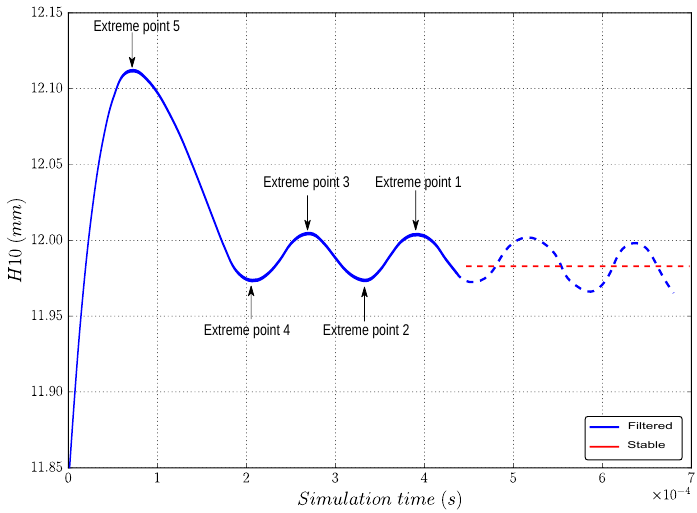
Figure 7. H 10 of dynamic tensile target with low frequency